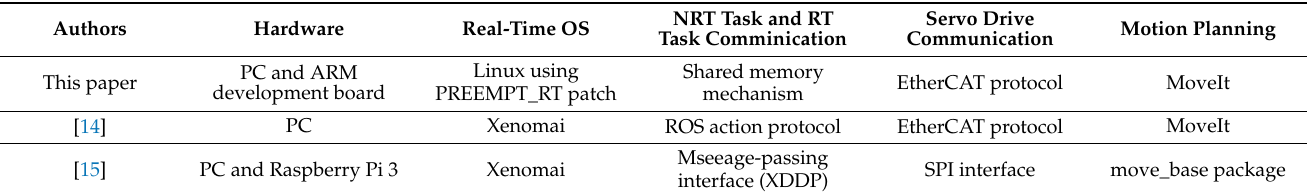
Table 1. Comparison of proposed architecture and other